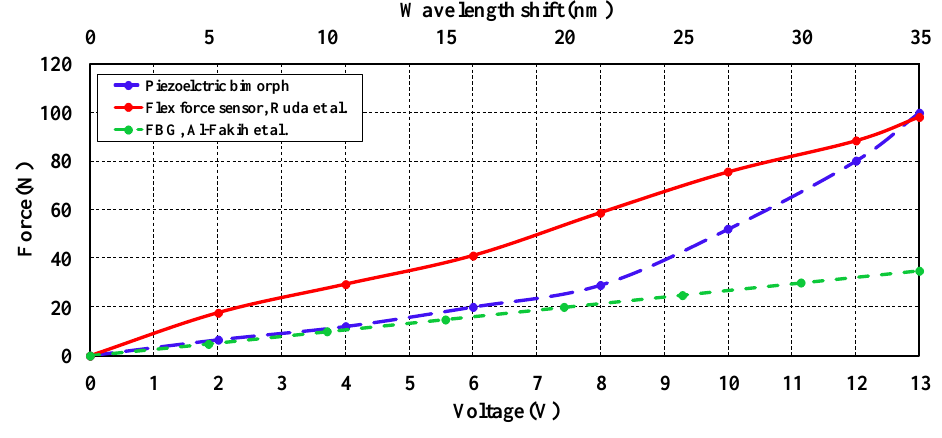
Figure 10. Static force characteristics of piezoelectric bimorph and two different available force sensors.